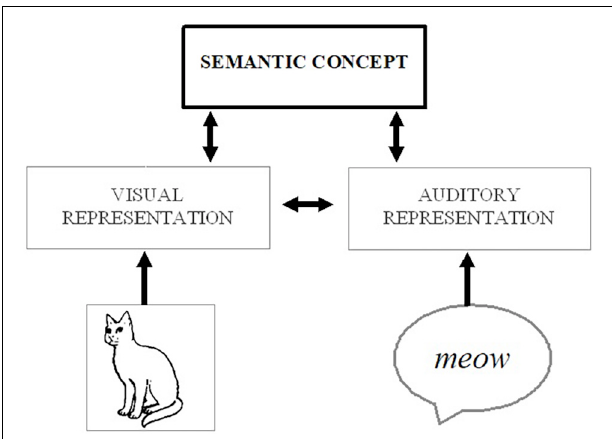
FIGURE 1 | Possible processing route whereby activation from auditory (e.g., a meowing sound) or visual (e.g., a picture of a cat) stimuli could spread to a corresponding conceptual representation (e.g., of a cat) and associated visual features, thereby strengthening the salience of the visual